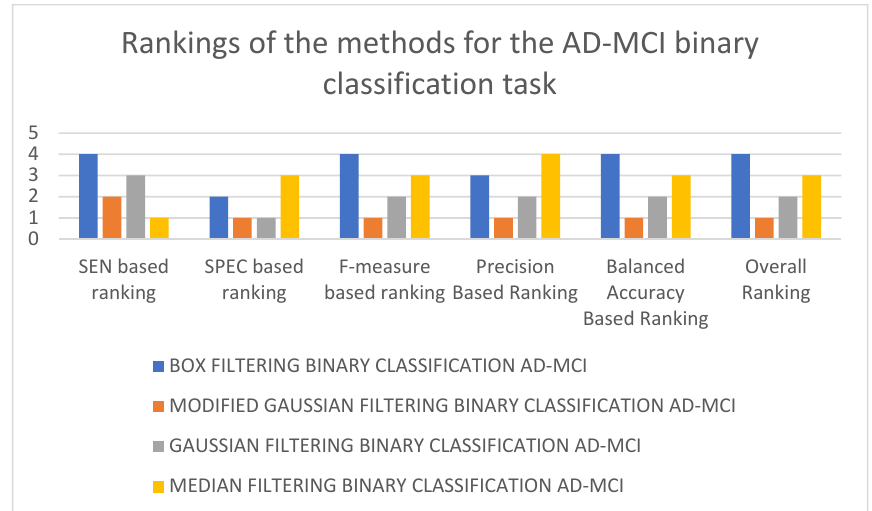
Figure 6. Rankings of different 3D-CNN architectures for the AD-MCI binary classification task.